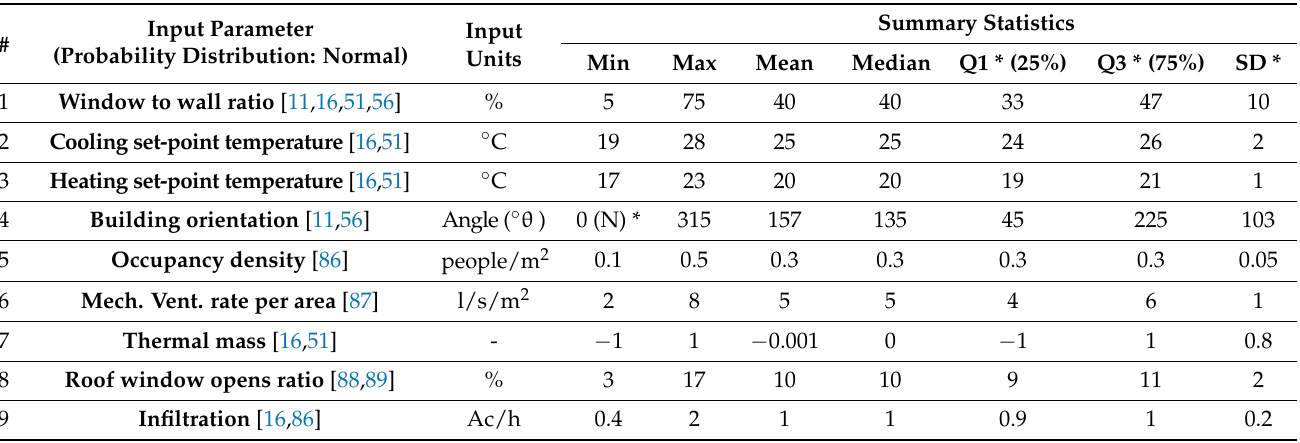
Table 1. Statistical output and distribution profiles for normal distribution characteristics of in- put